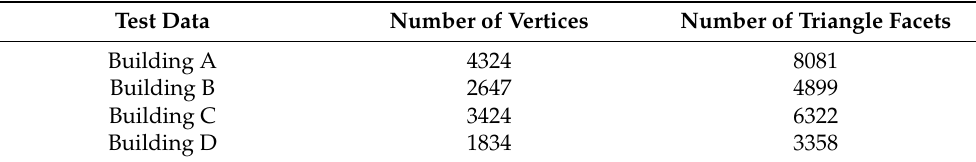
Table 1. The basic information of the selected